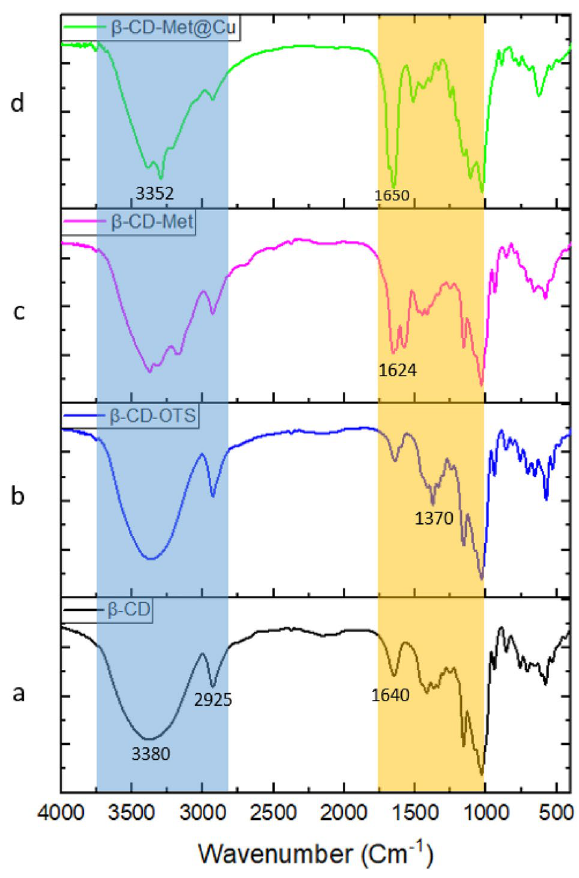
Figure 2. FT-IR spectra of ( a ) β-Cyclodextrin, ( b ) β-CD-OTs, ( c ) β-CD-Met, and ( d ) Cu@Met-β ‐ CD.